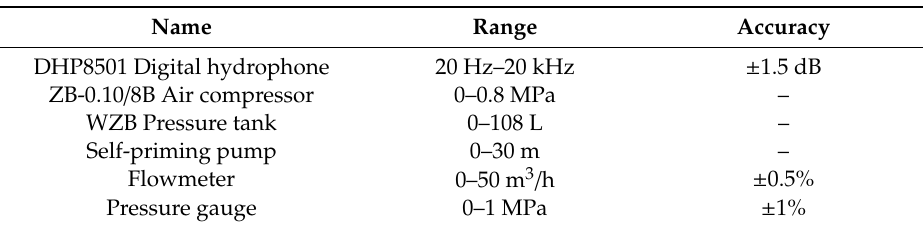
Table 1. Test equipment.